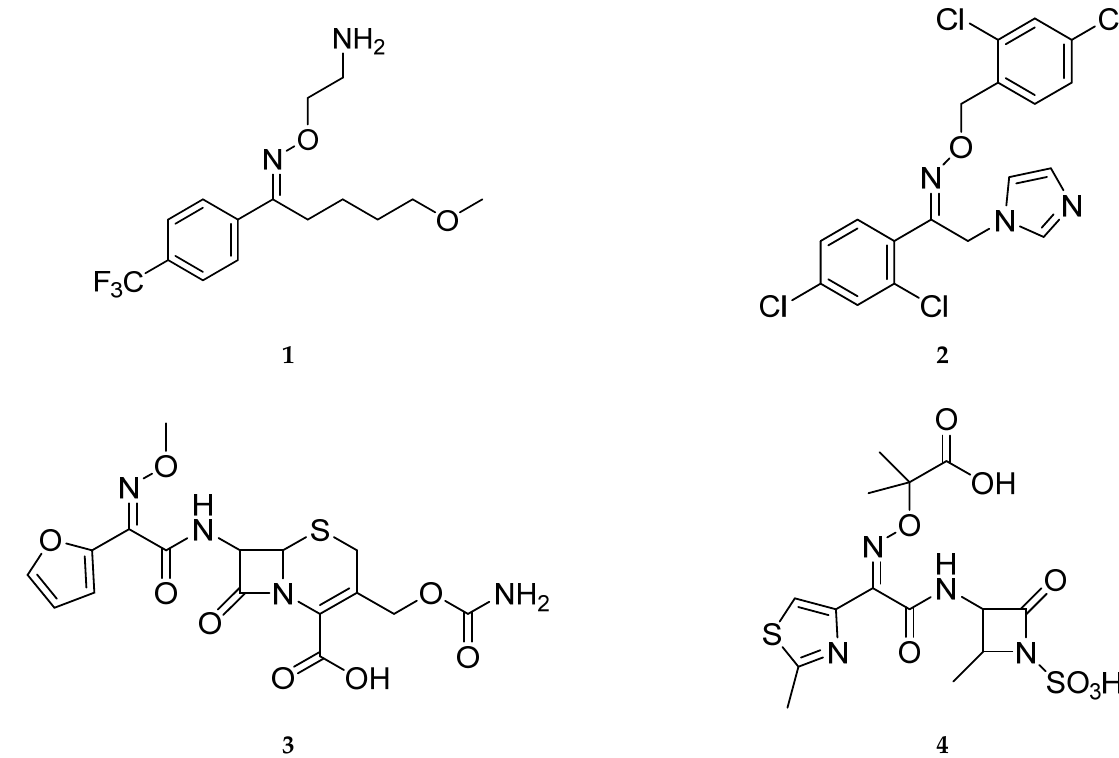
Figure 1. Structure of drugs with an oxime ether structure: fluvoxamine ( 1 ), oxiconazole ( 2 ), cefuroxime ( 3 ), and aztreonam ( 4 ).